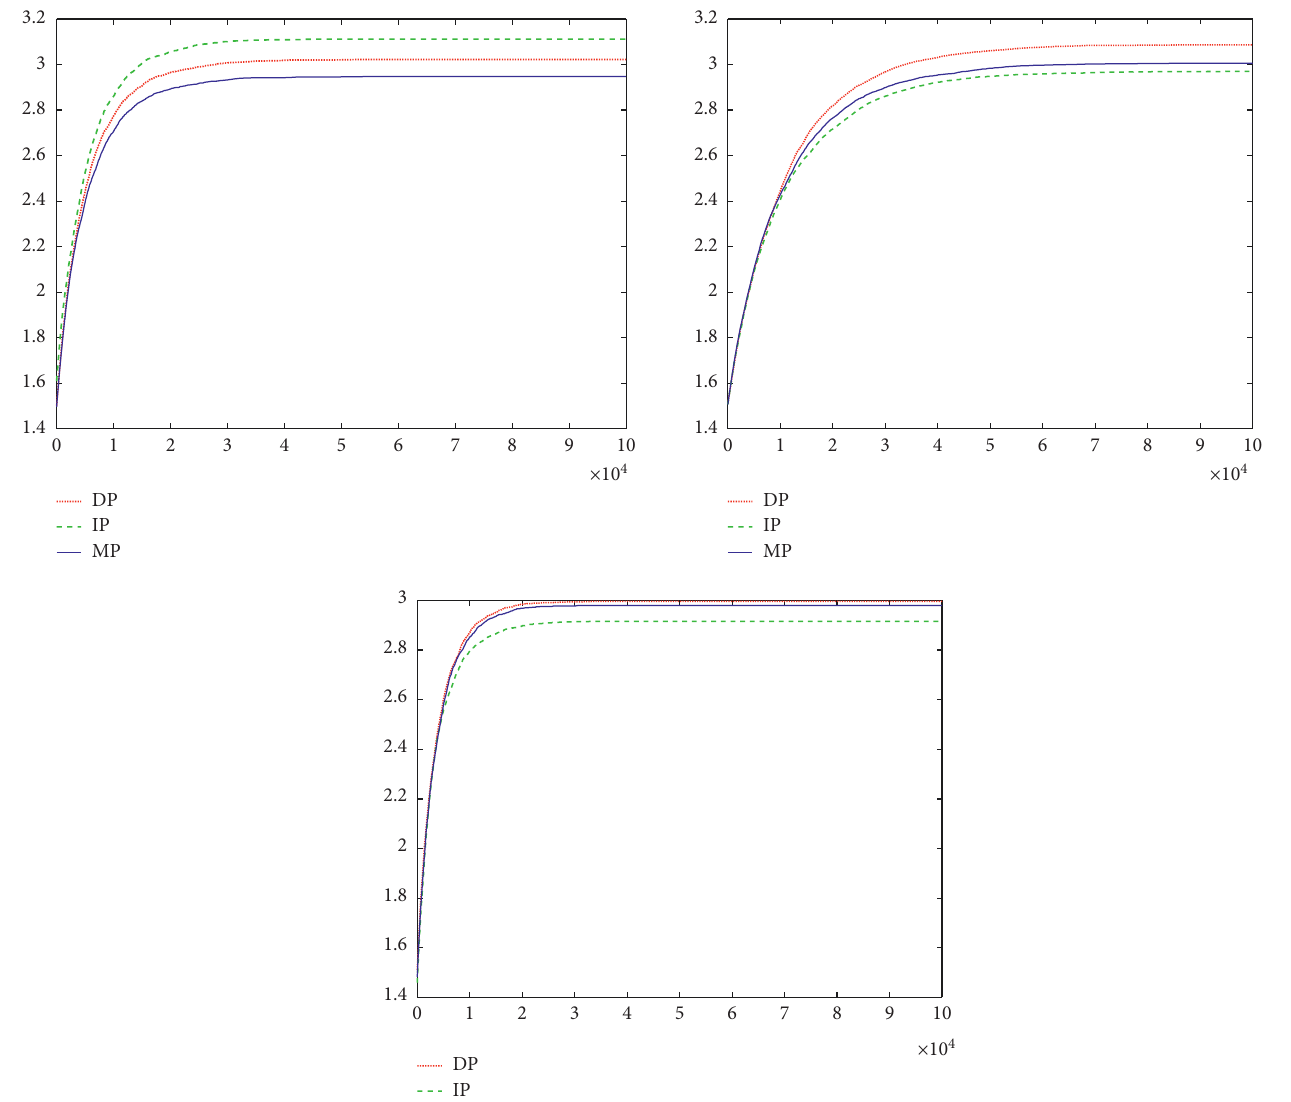
Figure 4: Levels of average knowledge in a scale-free network when k � 2, 4, and